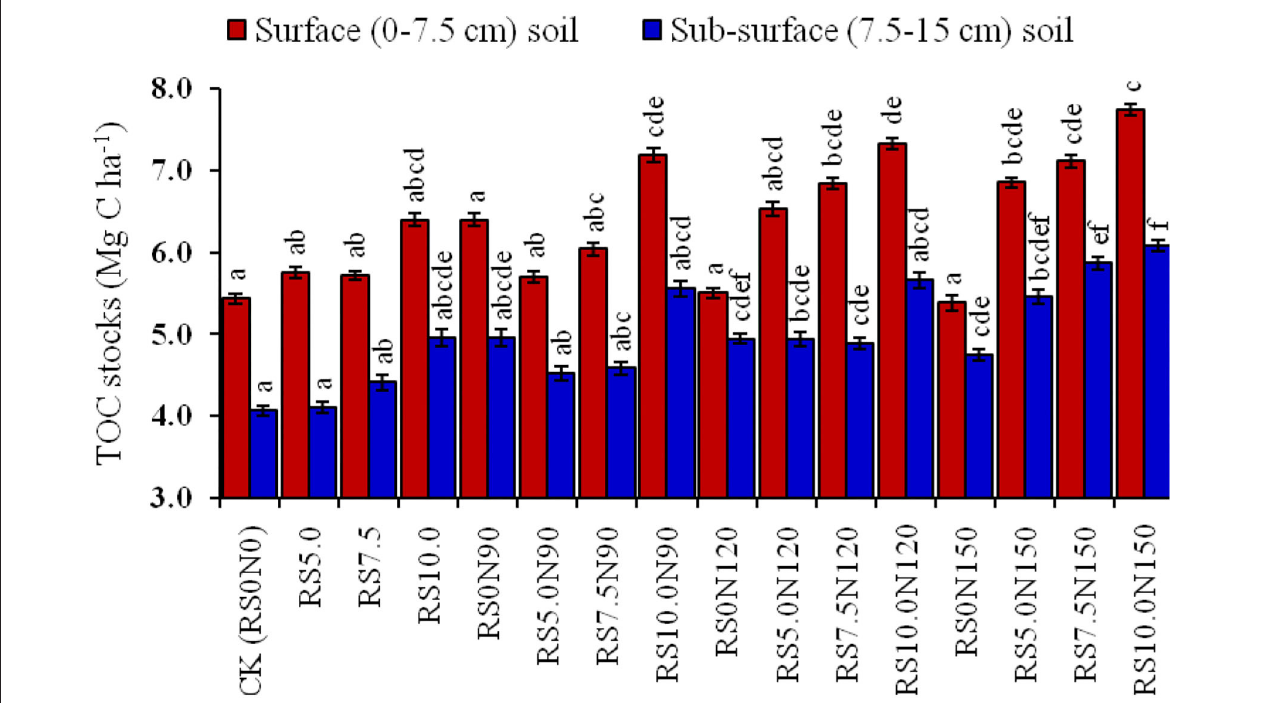
FIGURE 3 | Effect of fertilizer-N application and rice straw (RS) incorporation TOC stock (Mg m − 3 ) in the surface (0–7.5cm) and sub-surface (7.5–15cm) soil depth under rice-wheat cropping system in north-western India. Line bars indicate standard error from mean . The values for a soil depth, followed by different letters are significantly different at p < 0.05 by Duncan’s multiple range test (DMRT).